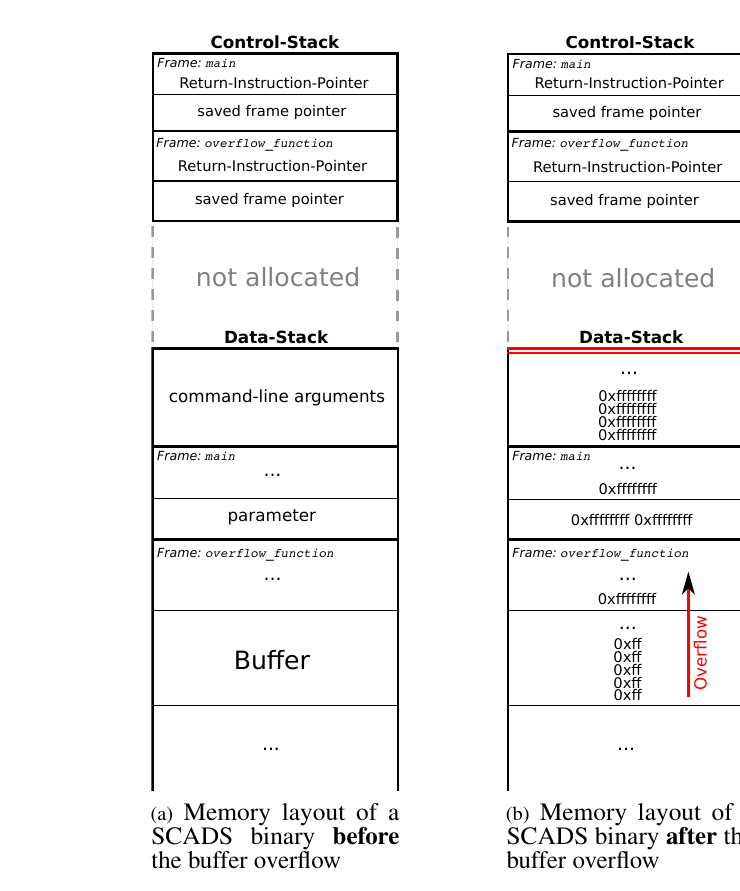
Figure 7. Memory layout of the exploit framework described by listing 11 compiled with